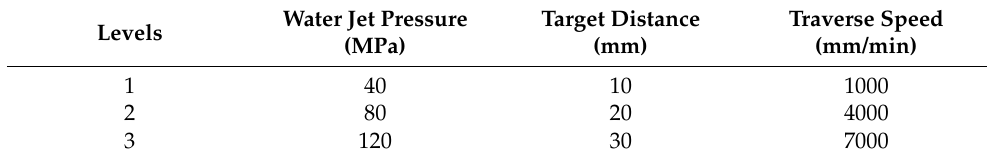
Table 1. The levels of factors in all-factor stem cutting